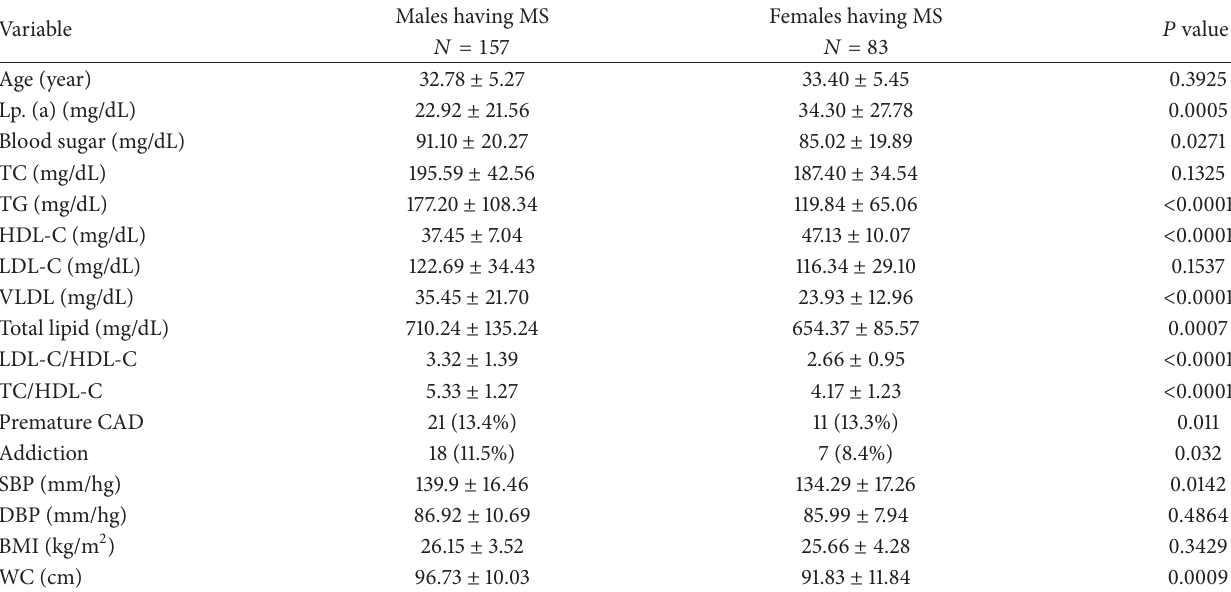
Table 3: Influence of gender on prevalence and profile of metabolic syndrome.